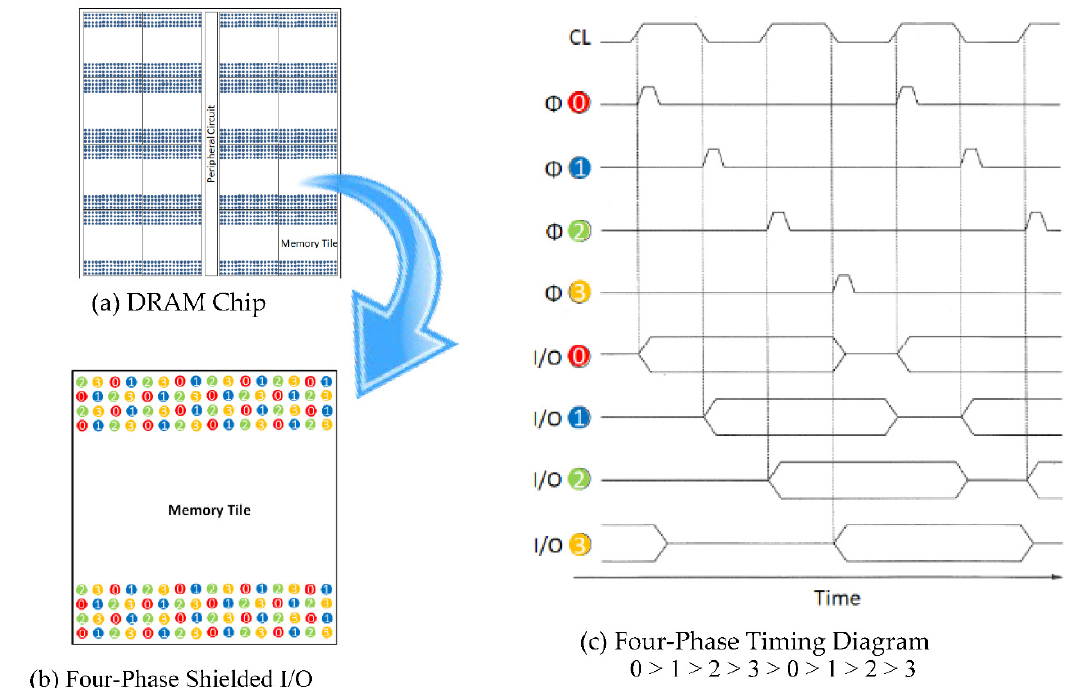
Figure 40. Four-Phase Shielded I/O Scheme.